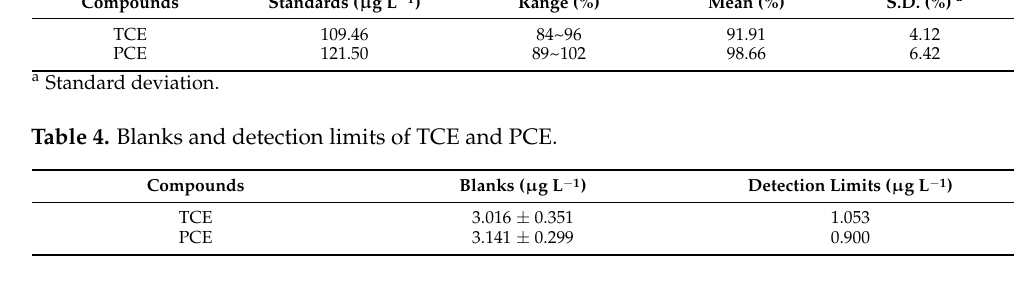
Table 5. Relative standard deviation (R.S.D.; %) of samples adsorbed by activated carbon (n = 4). Sample